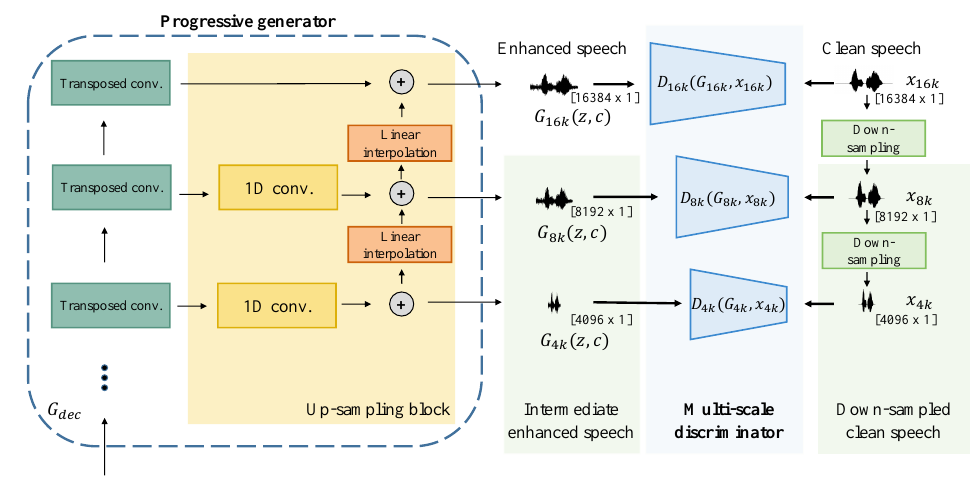
Figure 3. Illustration of the progressive generator and the multi-scale discriminator. Sub- discriminators calculate the relativism score D n ( G n , x n ) = σ ( C n ( x r The figure is the case when p , q = 4 k , but it can be extended for any p and q . In our experiment, we covered that p and q were from 1 k to 16 k